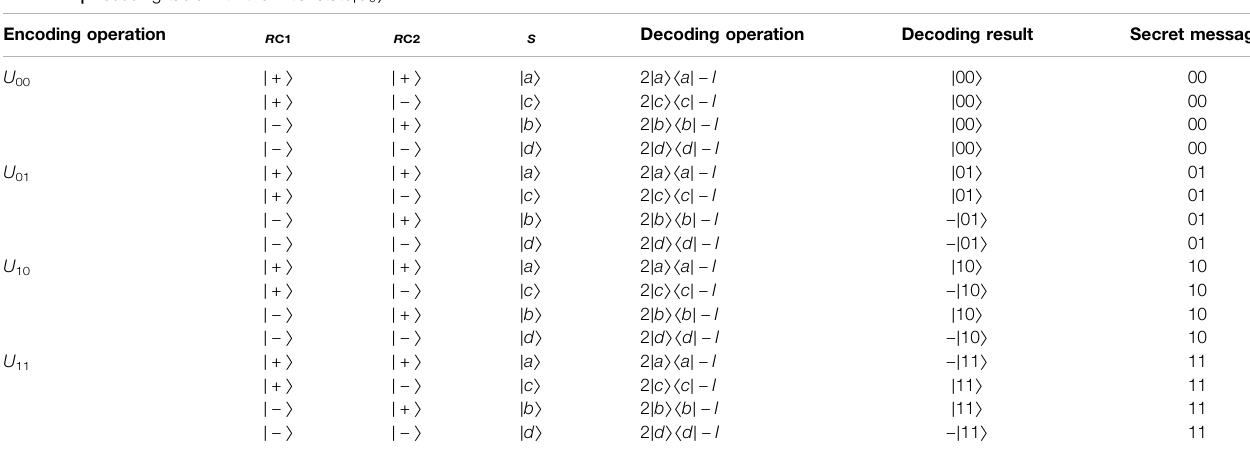
TABLE 2 | Decoding table with the initial state | C 0 〉 . Encoding